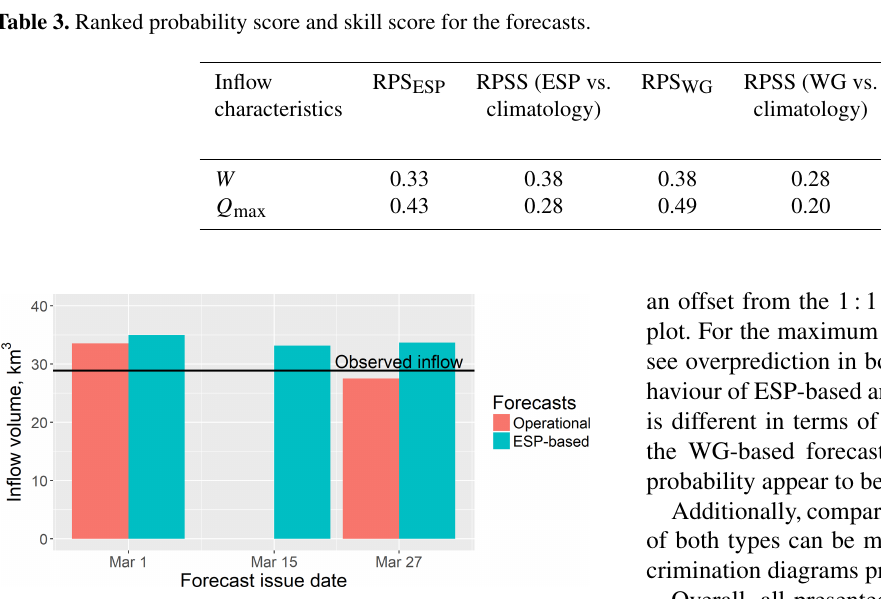
Figure 8. The ESP-based and operational forecasts of volume of water inflow into the Cheboksary Reservoir for the period from 1 April till 30 June 2017 (the line indicates the observed